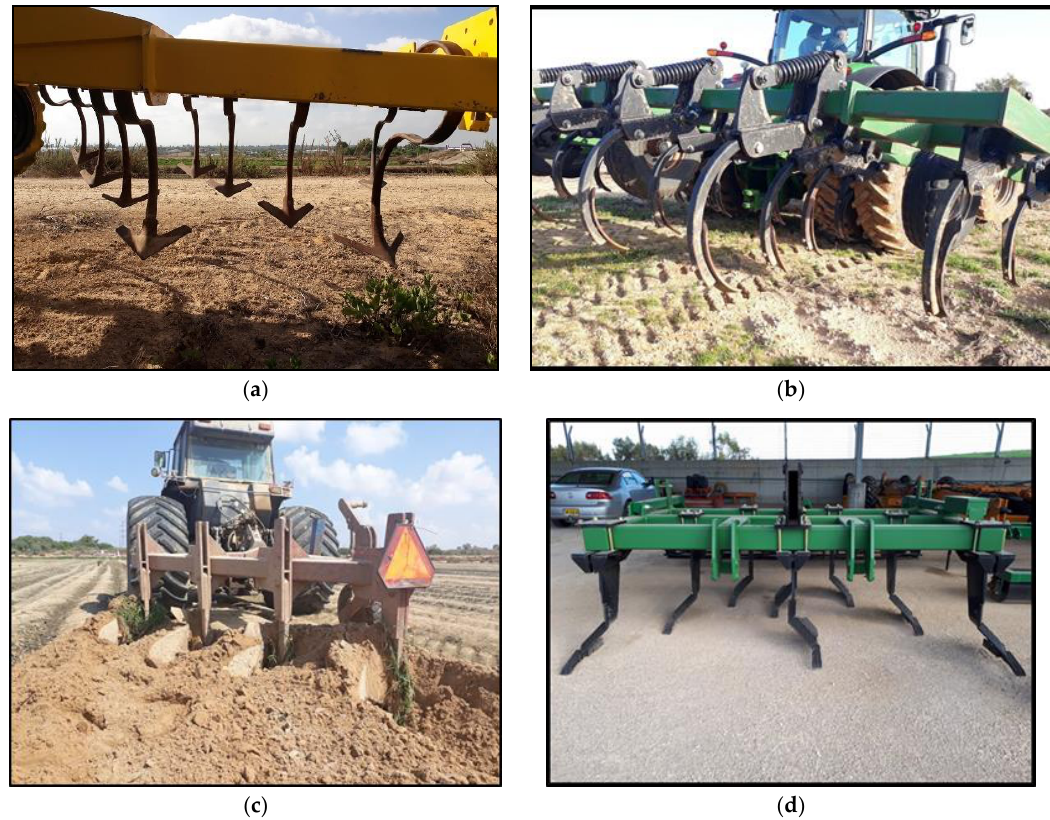
Figure 2. Tillage tools used during the experiment: ( a ) Sweep-knives (SK) cultivator; ( b ) Chisel-knives (CK) cultivator; ( c ) Plow; ( d ) Subsoiler (paraplow type).